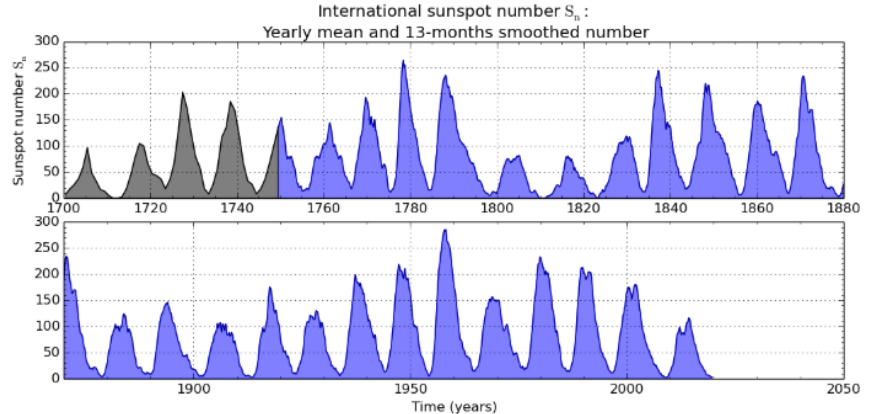
Figure 1. Observation of SSN over the years in cycles [37].